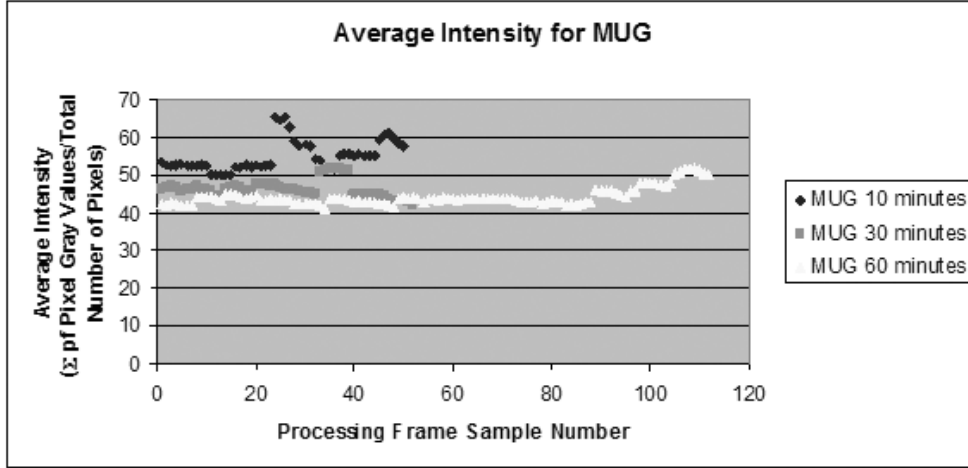
Figure 16: Average Intensity of wear for MUG after each stage of the